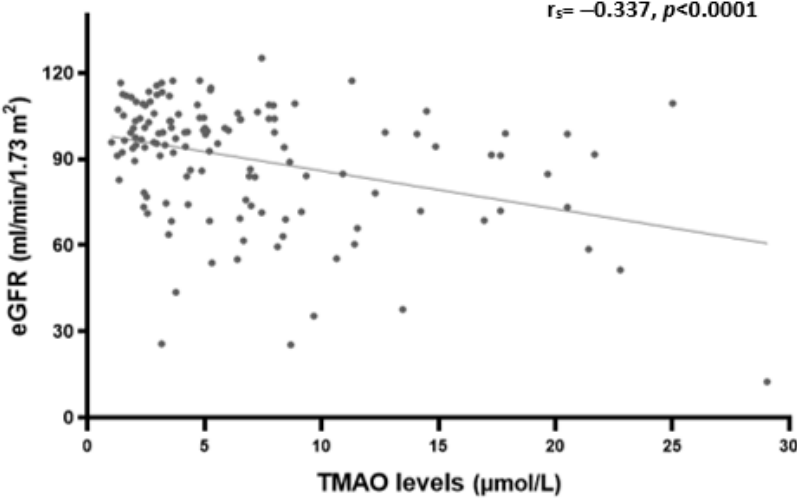
Figure 2. Spearman’s rank correlation analysis between plasma TMAO levels and eGFR.